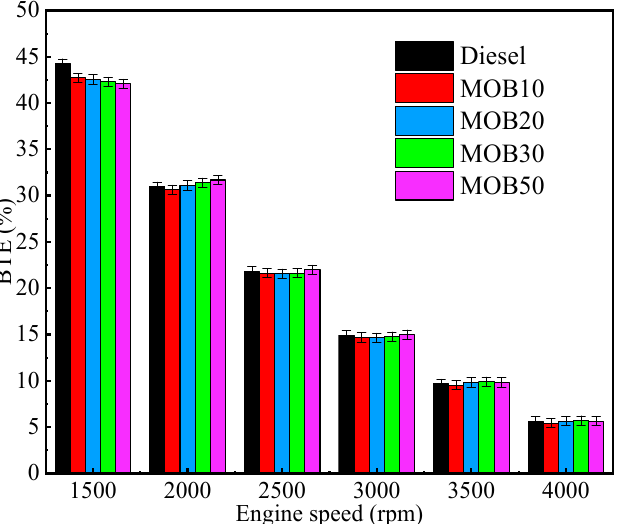
Figure 13. BTE of Moringa oil biodiesel blends at different engine speeds [172].